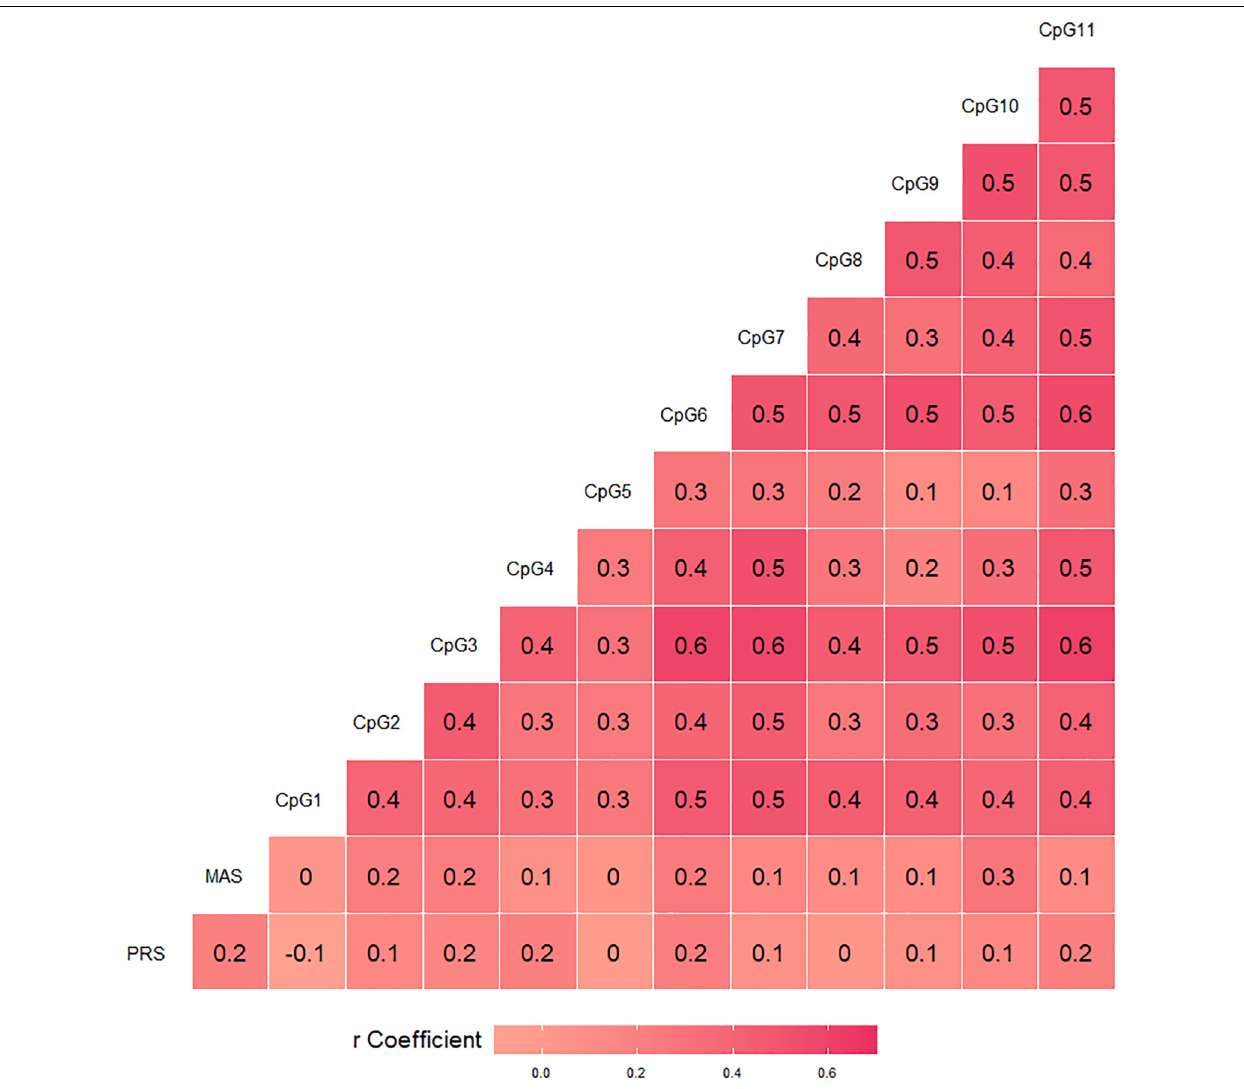
FIGURE 2 | Bivariate correlations of BDNF CpG-specific percentage methylation with pandemic-related stress (PRS) during pregnancy and postnatal maternal anxious symptoms